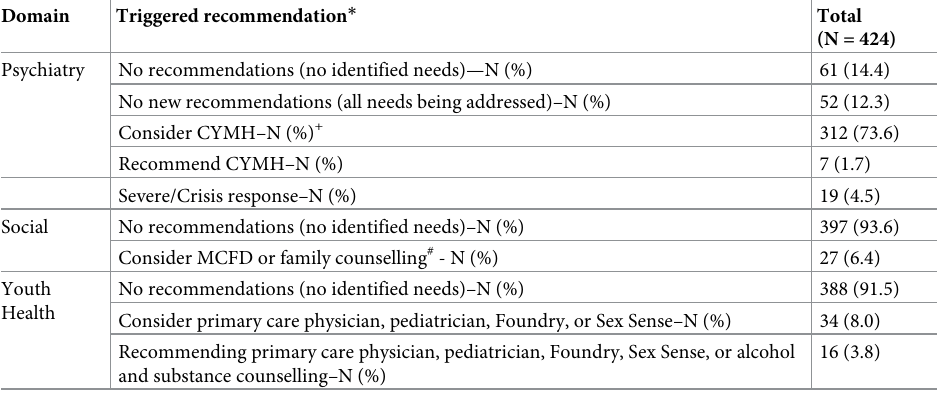
Table 2. MyHEARTSMAP-generated mental health resource and social support recommendations for assess- ments completed by youths and